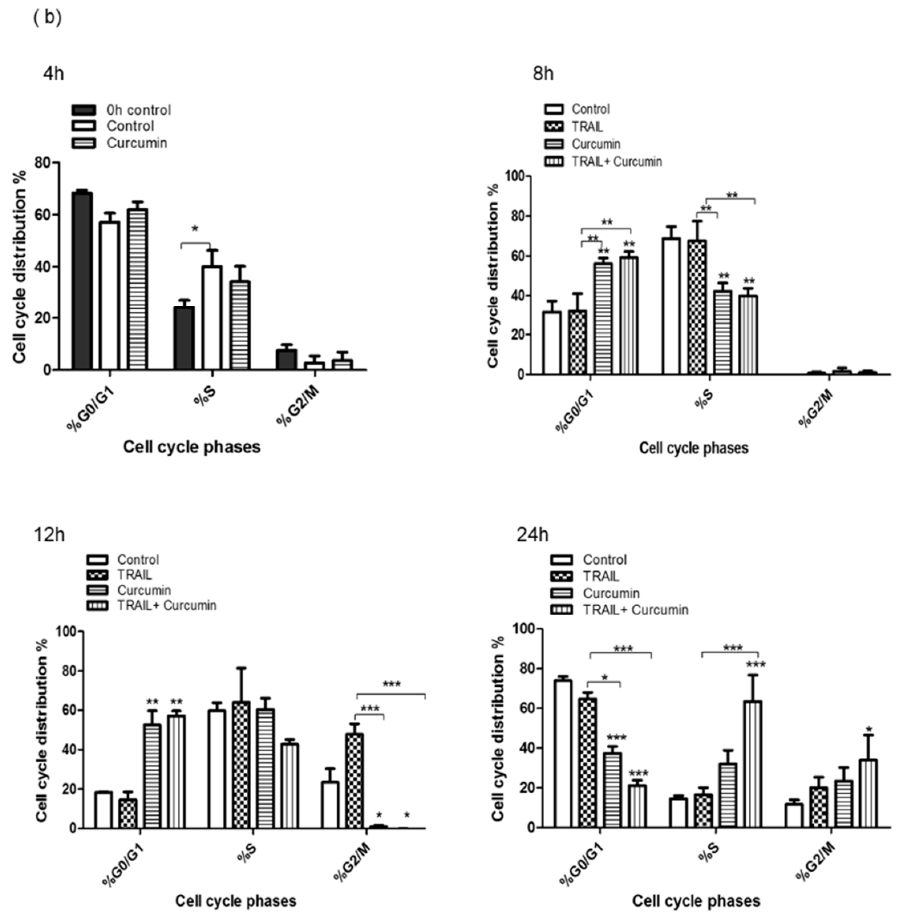
Figure 3. Effects of curcumin, TRAIL, curcumin+ TRAIL combination on ACHN cell cycle. Cell cycle was examined by flow cytometry with a solid-state blue laser (488 nm) and fluorescence emissions were detected using 575/25 nm filter (FL2). Cells were fixed 70% ethanol and nuclear DNA (nDNA) was labelled with Propidium Iodide (PI). ( a ) Representative histograms show the percentage of cells residing at each cell cycle (G0/G1, S, and G2/M) phase following the exposure to DMSO, TRAIL, curcumin and curcumin+ TRAIL for different times. At the beginning, cell cycle profile was assessed before adding any treatment (a-0 h). Curcumin was then added for 4 h, and cell cycle profile was measured and compared with the corresponding untreated control (a-4 h). After 4 h, TRAIL was added and incubated for a further 4 h (a-8 h), 8 h (a-12 h) or 20 h (a-24 h). Data were analysed using TWO-WAY ANOVA. ( b ) Statistical analysis of cell cycle histograms. Each histogram shows the percentage of cells residing at each cell cycle phase following exposure to the indicated treatments. Cell populations accumulated at each cell cycle (G0/G1, S, and G2M) phase were measured, analysed, and compared. Data are expressed as mean± SEM of three independent experiments. * p < 0.05, ** p < 0.01, *** p < 0.001 compared to the vehicle control or TRAIL treated cells. Different bar patterns were used to indicate different treatments and are indicated in the figure.